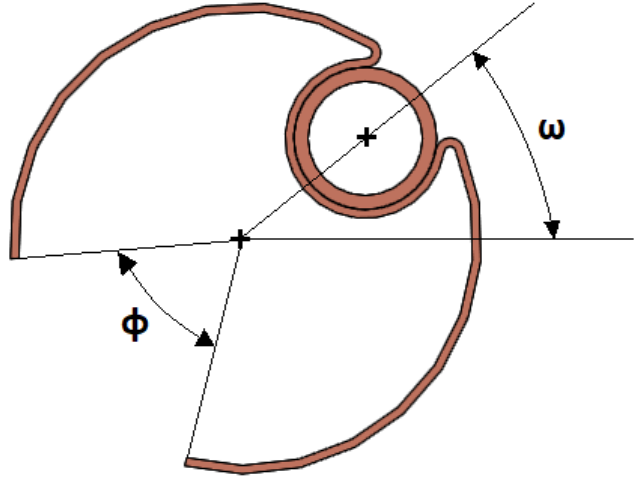
Figure 2. Parameters of optimization.